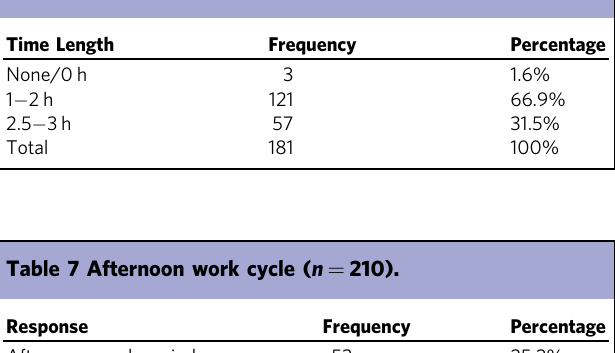
Table 6 Length of morning work cycle ( n = 181, exclude 0 − 3-year-old classroom teachers).